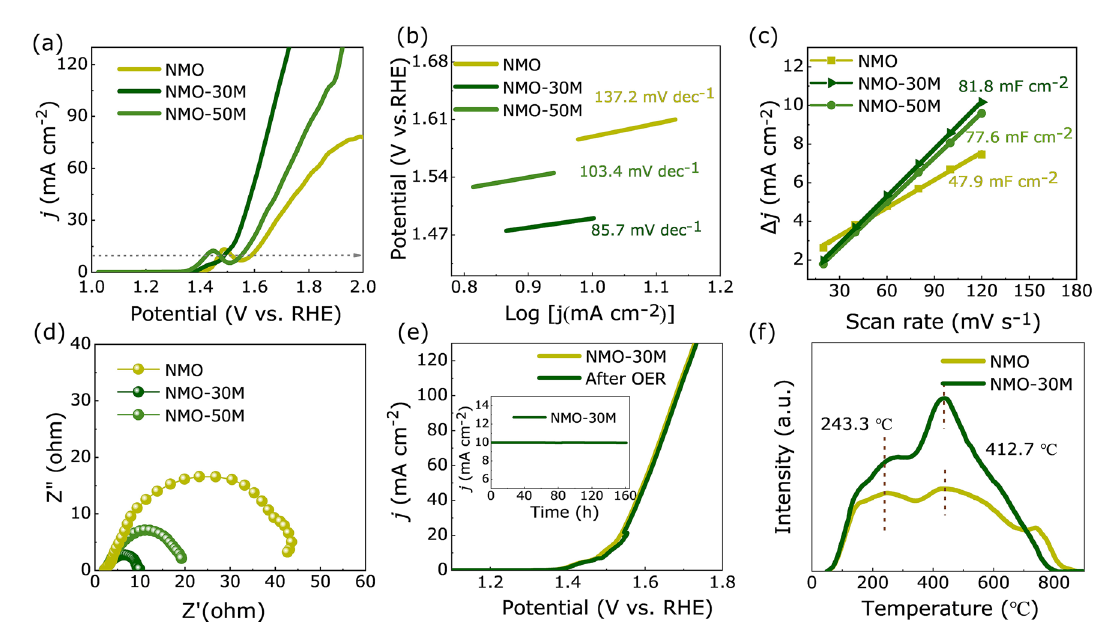
Fig. 3 Electrochemical performance tests of catalysts. a Polarization curves and b the corresponding Tafel plots of NMO, NMO-30M and NMO-50M. c C dl obtained by CV curves at 0.1 V versus Ag/AgCl. d EIS spectra of NMO, NMO-30M and NMO-50M. e LSV curve of NMO- 30M after cycles and the inset is i – t curve of NMO-30M at a potential of 1.6 V versus RHE. f O 2 -TPD profiles of NMO and